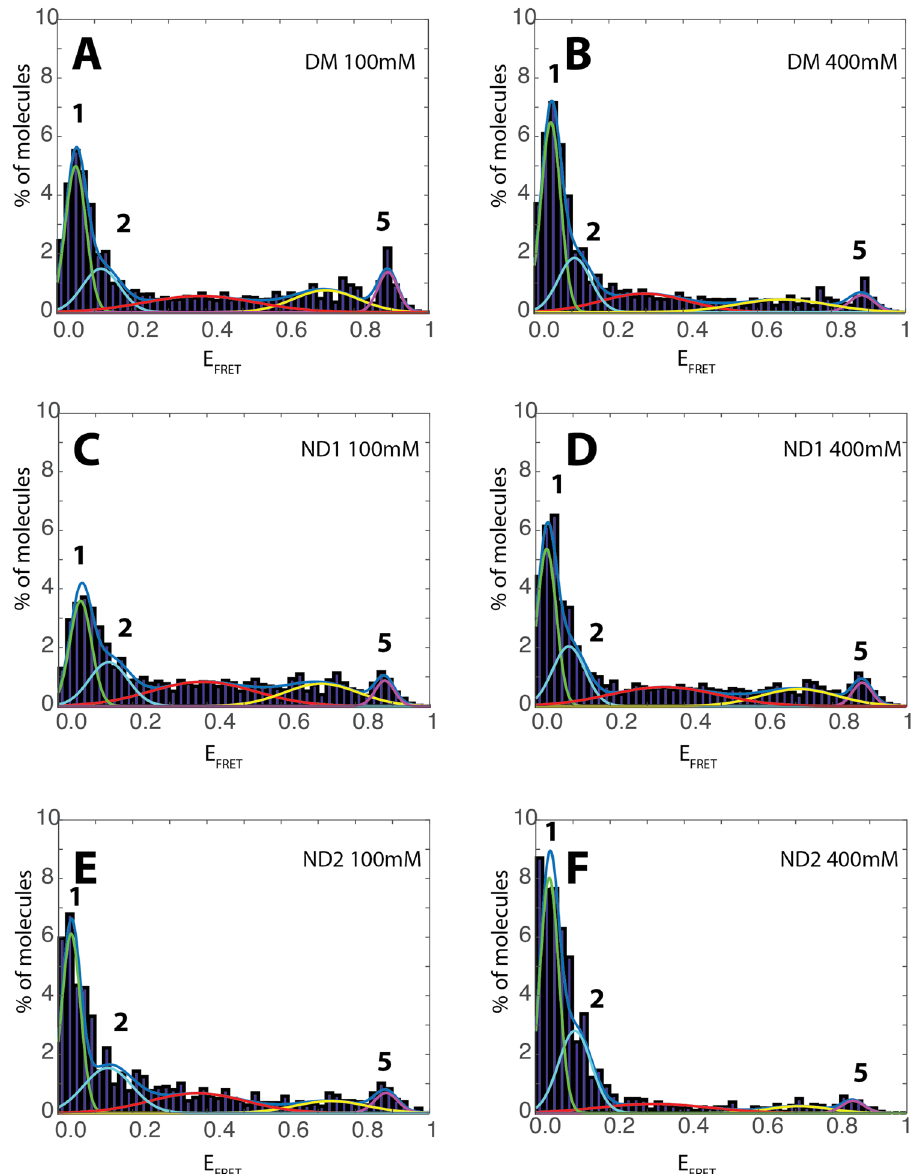
Figure 3. (A , C and E) E FRET histograms of POR conformational sampling in detergent micelles (DM) and nanodiscs (ND1 and ND2) and ( B,D and F ) their dependence on increased ionic strength. The two “low FRET” peaks (1, 2) and high FRET peak (5) are indicated by line colors green, cyan and purple